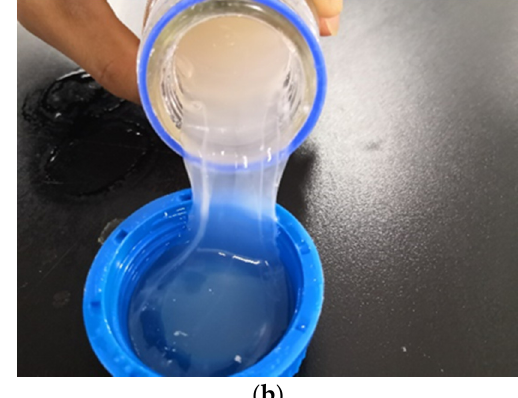
Figure 4. The newly configured gel system ( a ) and the gel system after gelation ( b )